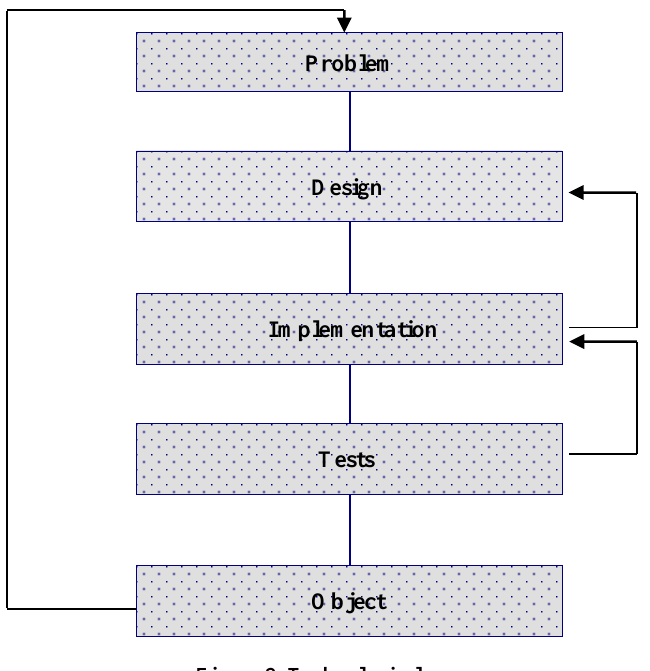
Figure 2. Technological